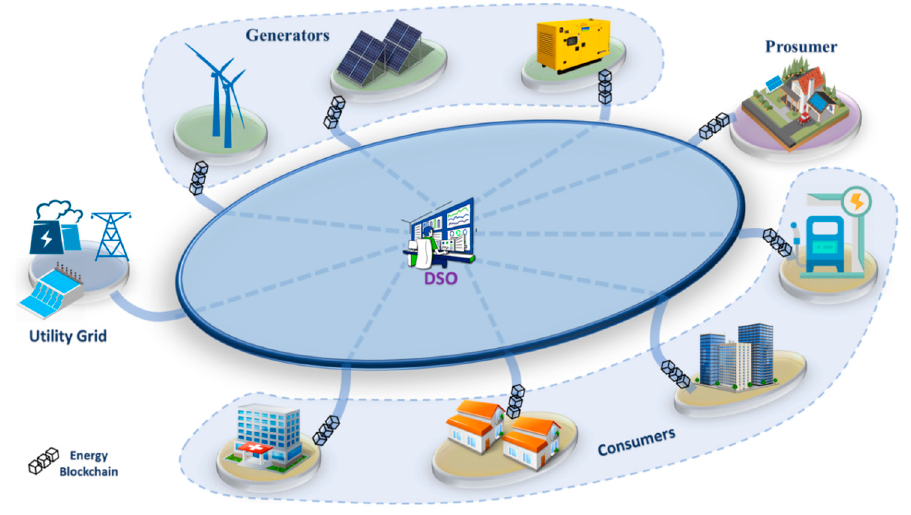
Figure 1. General architecture of the proposed model using blockchain technology.